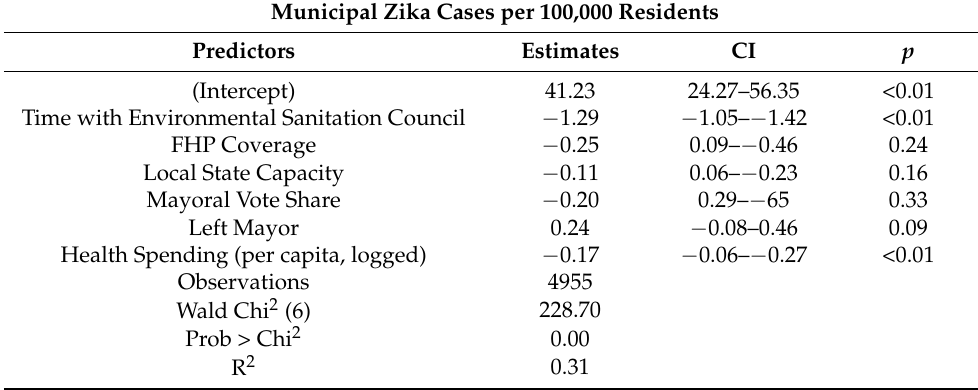
Table 4. Maturity of Environmental Sanitation Policy Councils and Zika, 2016–2017. This table reports the results OLS estimation following pre-processing through Coarsened Exact Matching for each year that municipalities used an environmental sanitation